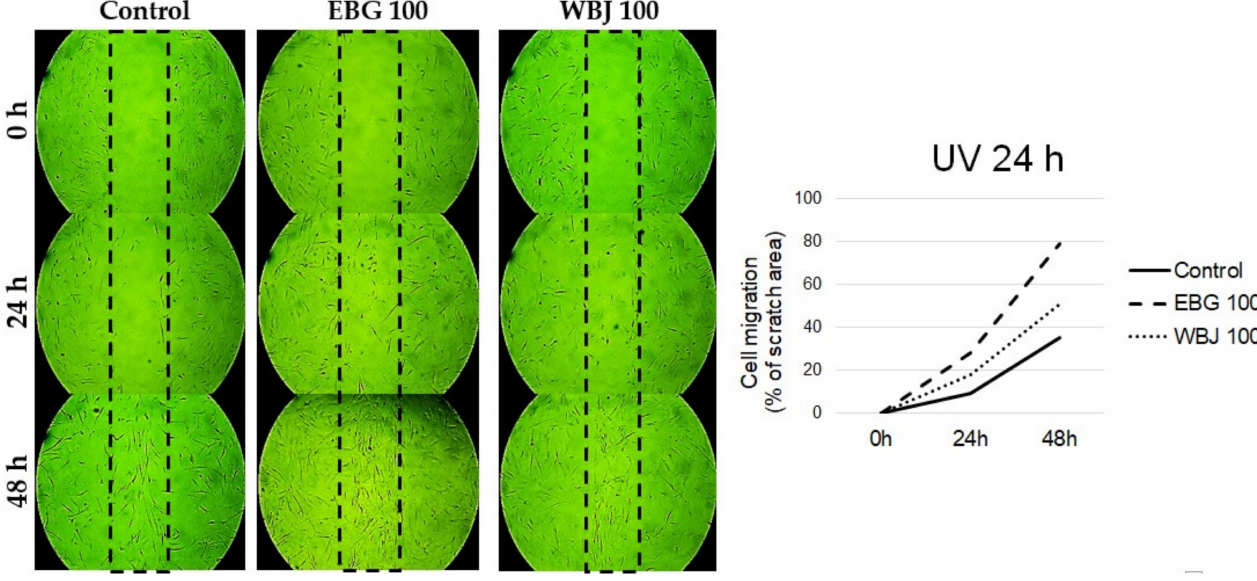
Figure 12. Effect of 70% ethanolic extract of barley grass (EBG) and 100 µ g/mL water extract of young barley juice (WBJ) on the migration of NHSF cell line in “UV 24 h”